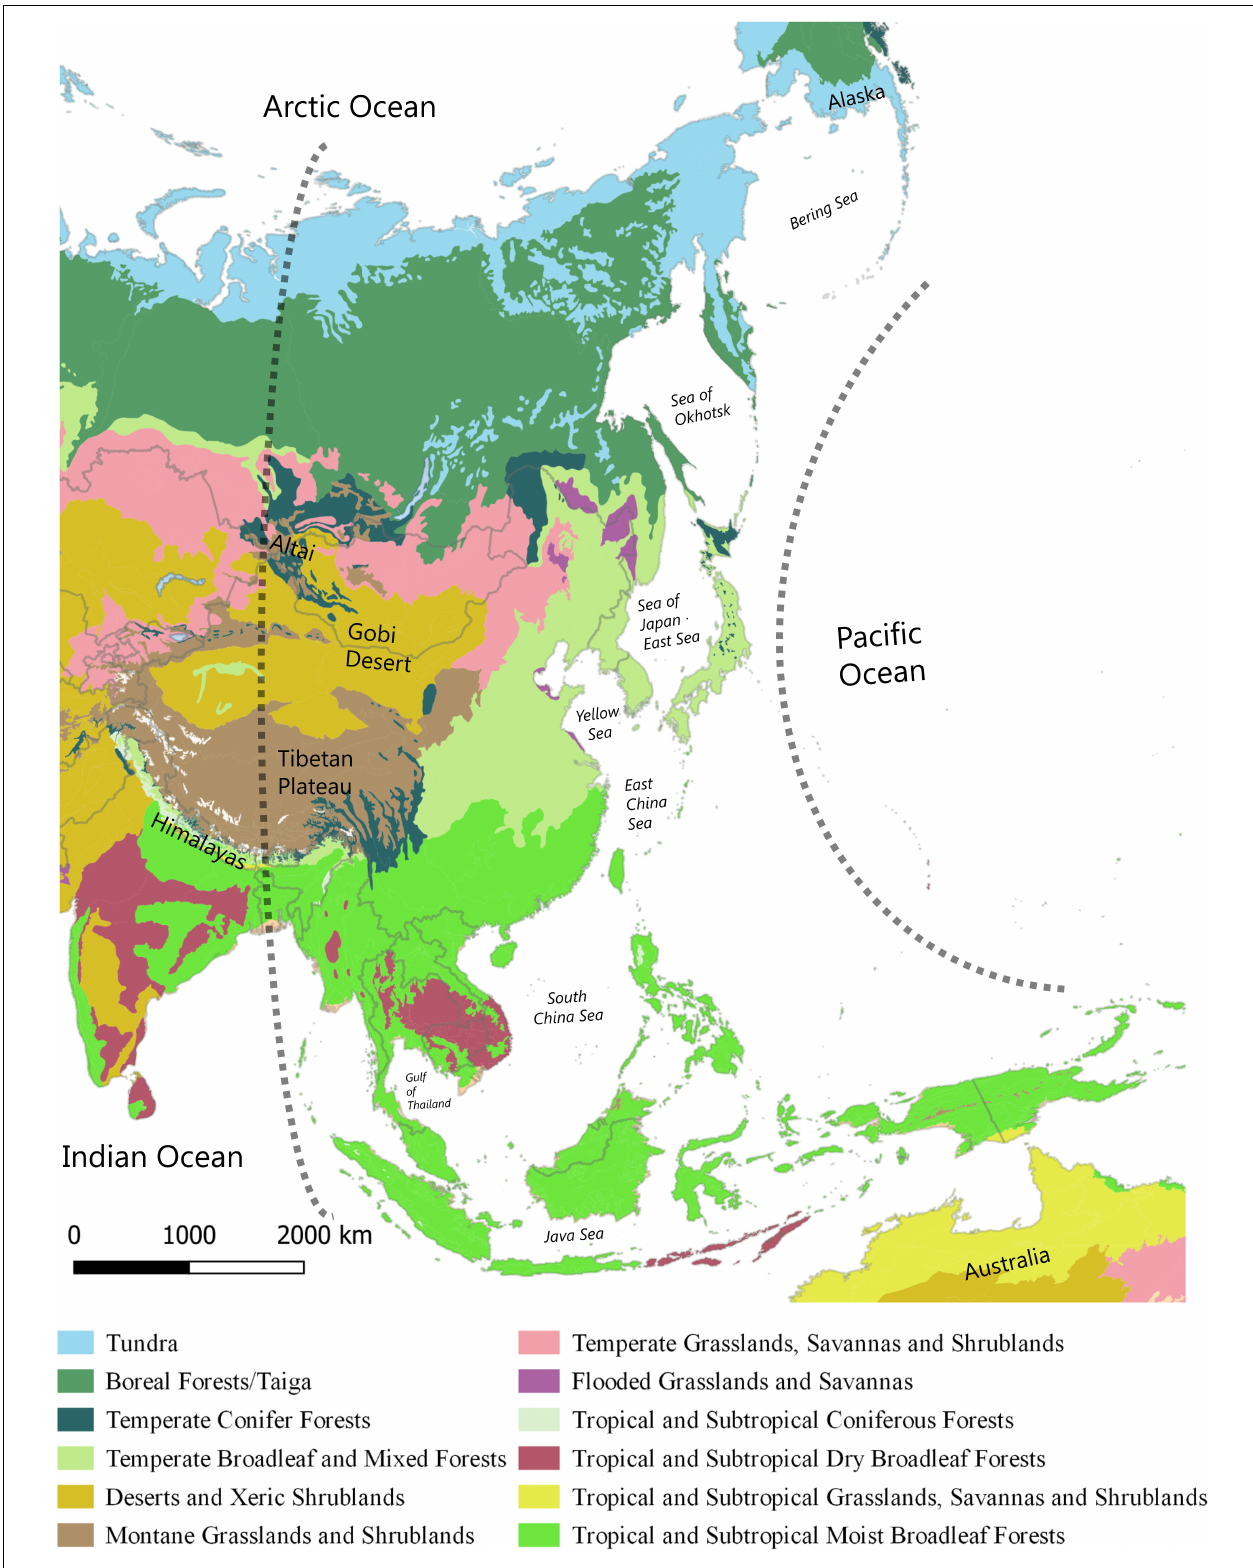
FIGURE 1 | The extent of the East Asian Flyway (EAF) bounded by the 90th meridian on the west and the Pacific Ocean on the east including boreal, temperate and tropical biomes. Data from The Nature Conservancy. Terrestrial ecoregions (2020). https://tnc.maps.arcgis.com/home/item.html?id=7b7fb9d945544d41b3e7a914 94c42930 (accessed May 10, 2020).